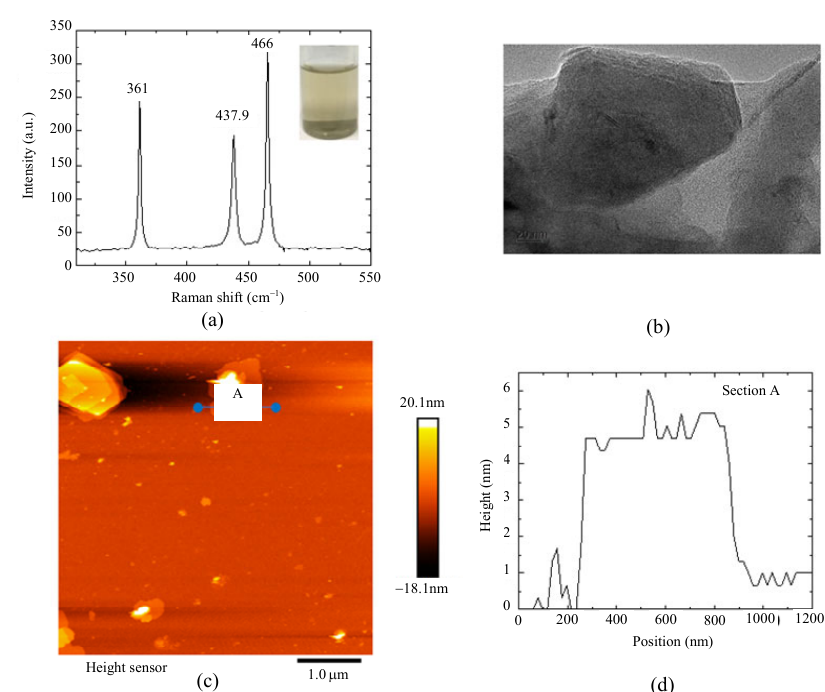
Fig. 1 Characterization of the exfoliated BP layers: (a) Raman spectrum of BP nanosheets (inset: photograph of a prepared BP solution), (b) TEM images of BP nanosheets, (c) AFM image of BP nanosheets, and (d) height profile marked in (c) ( x -axis represents the position along the line and y -axis is the corresponding height). BP: black phosphorus; TEM: transmission electron microscope; AFM: atomic force